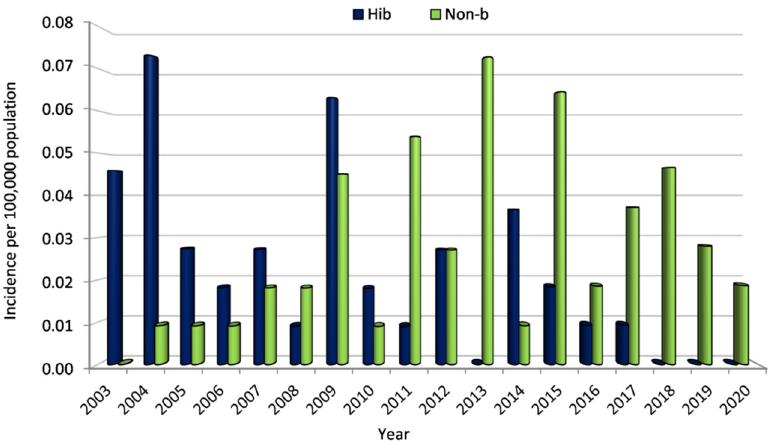
Figure 1. Incidence of H. influenzae b and non-b meningitis